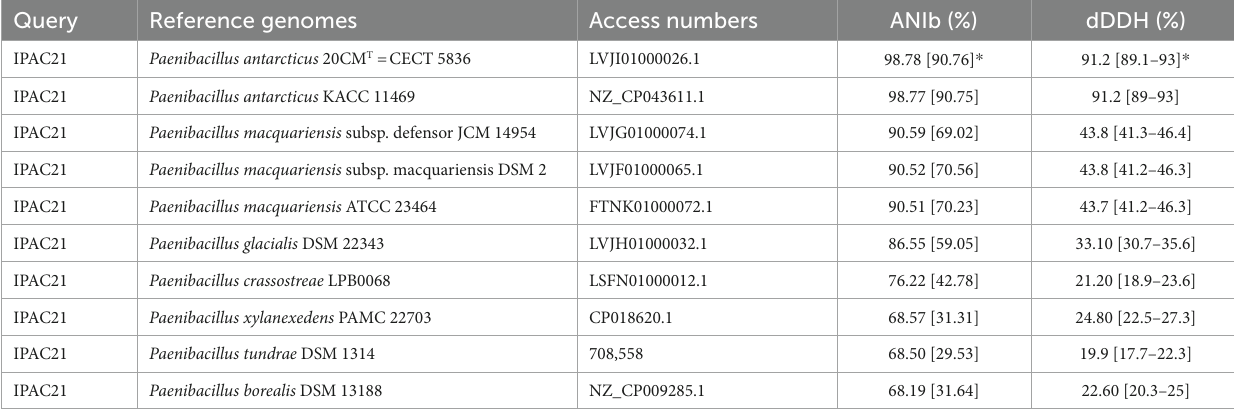
TABLE 1 Average nucleotide identity (ANI) and digital DNA–DNA hybridization (DDH) values between IPAC21 and closely related species of the genus